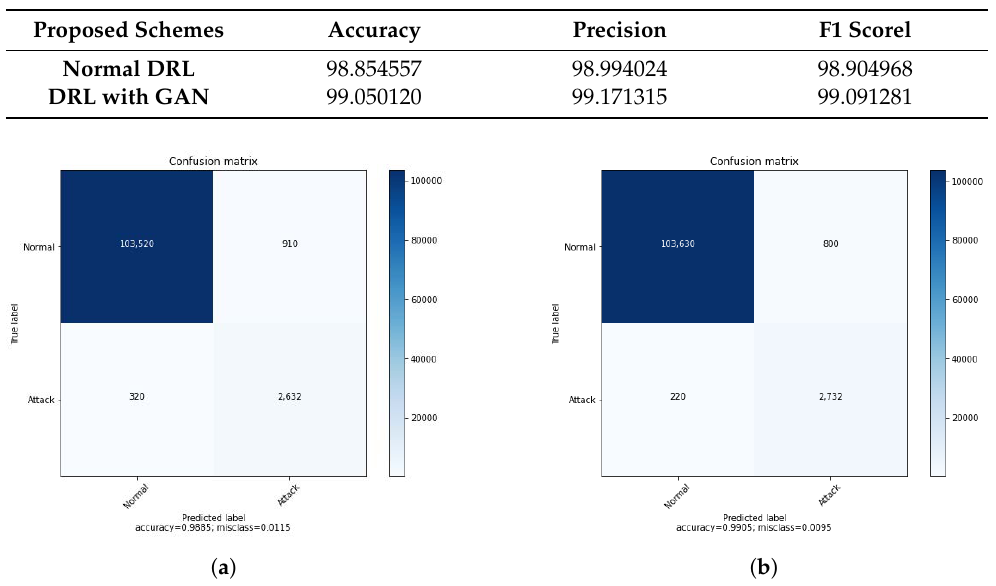
Figure 3. ConfusionMatrices of binary classification. ( a ) Normal DRL. ( b ) DRL with GAN.